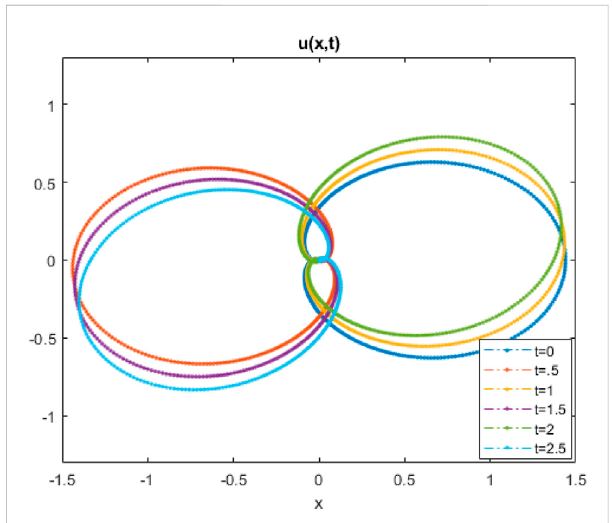
FIGURE 2 Trajectory of solution (3.4) with t for k = 1.5, c = 1.9, and γ = 3.